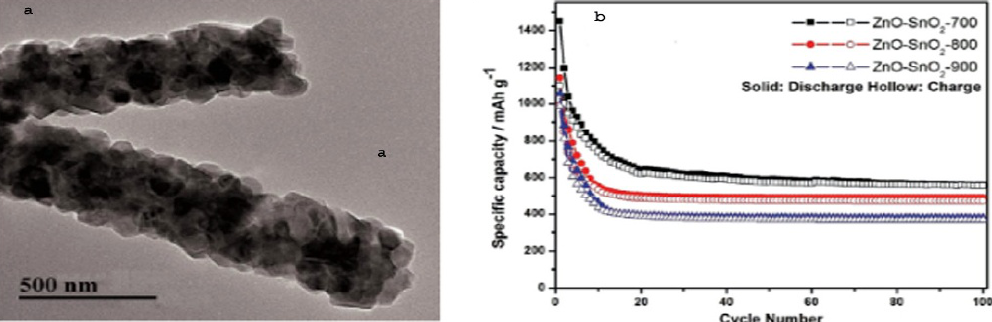
Fig. 8. (a) TEM images of ZnO–SnO2 composite nanofibers. (b) Cyclingperformance and coulombic efficiencies, reprinted with permission of Ref [59], Copyright 2016 Elsevier.